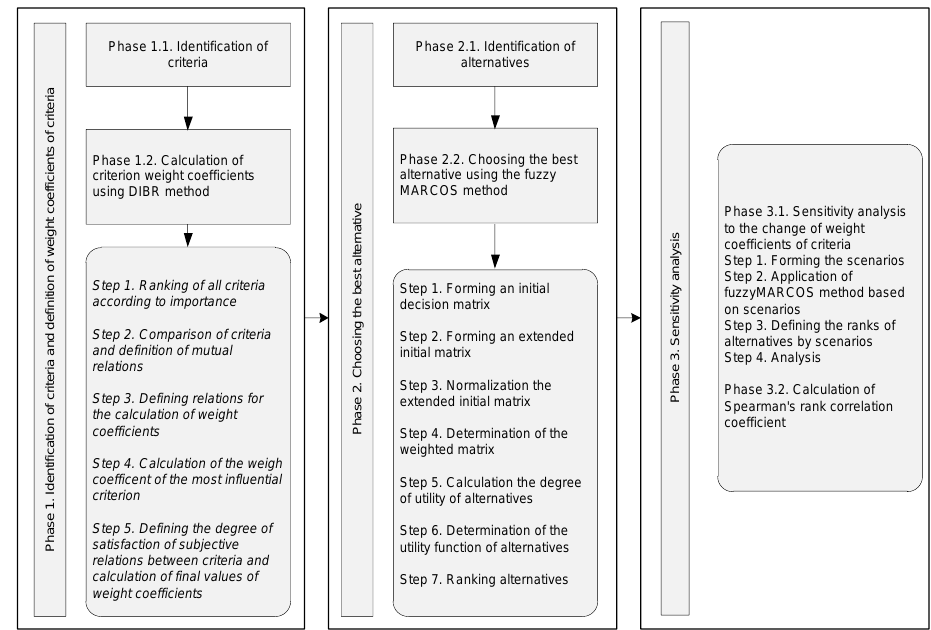
Figure 1 – Phases and steps for the application of the proposed MCDM methodology Рис. 1 – Этапы и шаги применения многокритериальной методологии принятия решений Слика 1 – Фазе и кораци за примену методологије вишекритеријумског